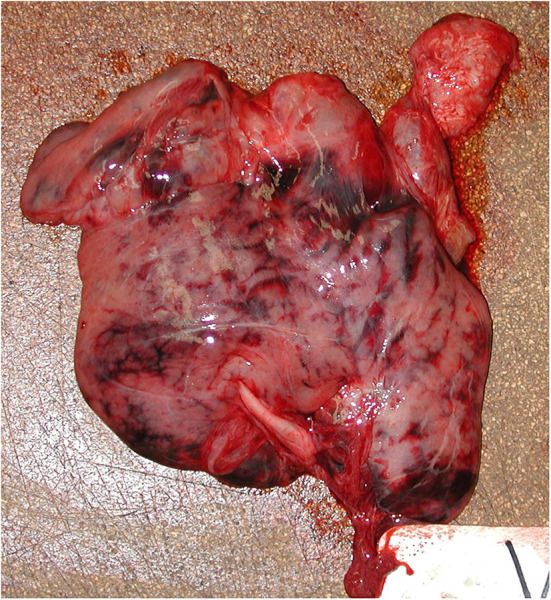
Pancreas, acute necrohemorrhagic pancreatitis, rough-toothed dolphin (case Y375). Pancreas has marked, multifocal to confluent, irregular dark red-maroon hemorrhages suffused within the parenchyma.